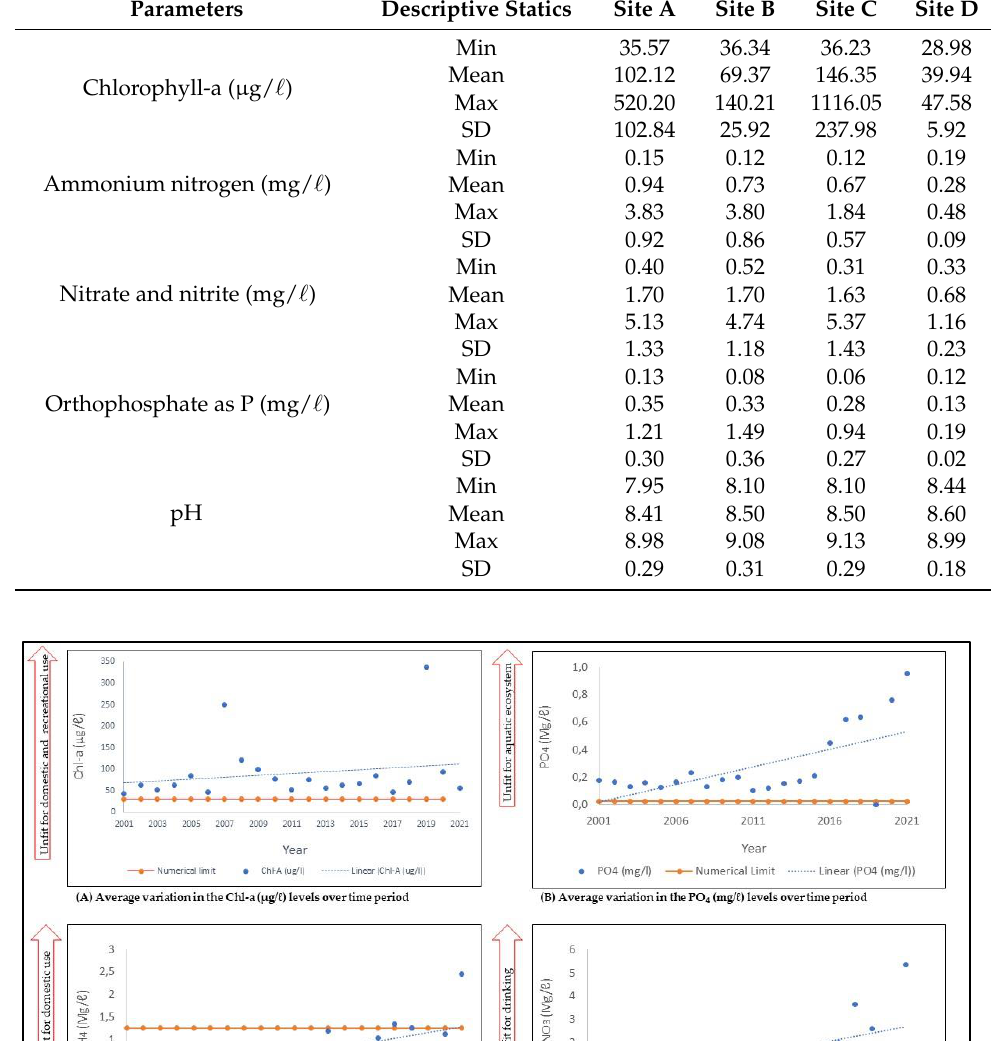
Table 4. Descriptive statistics of water quality across the four monitoring sites across the Roodeplaat Dam.